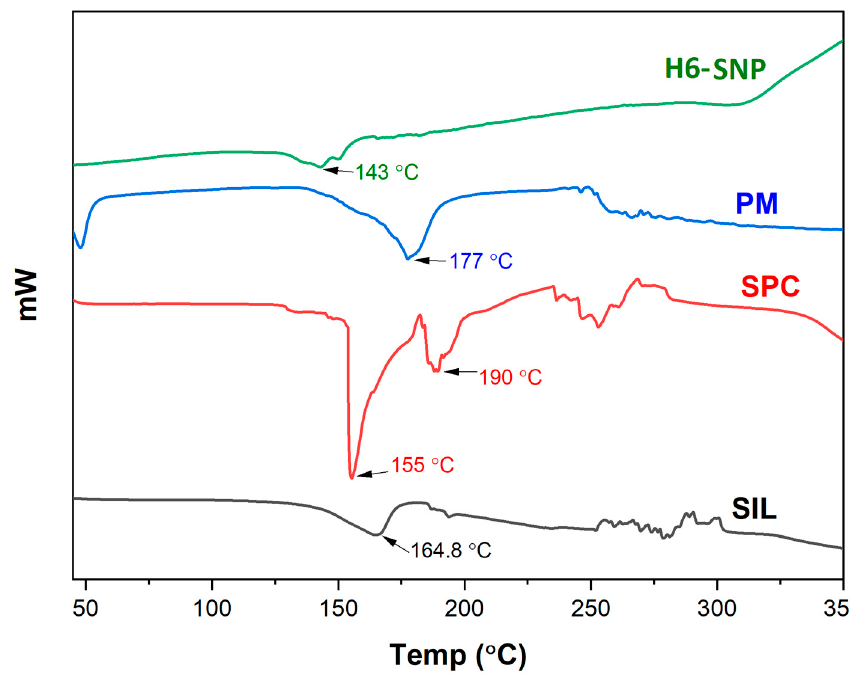
Figure 3. A Multiview Differential Scanning Calorimetry thermograms of SIL, SPC, PM and H6-